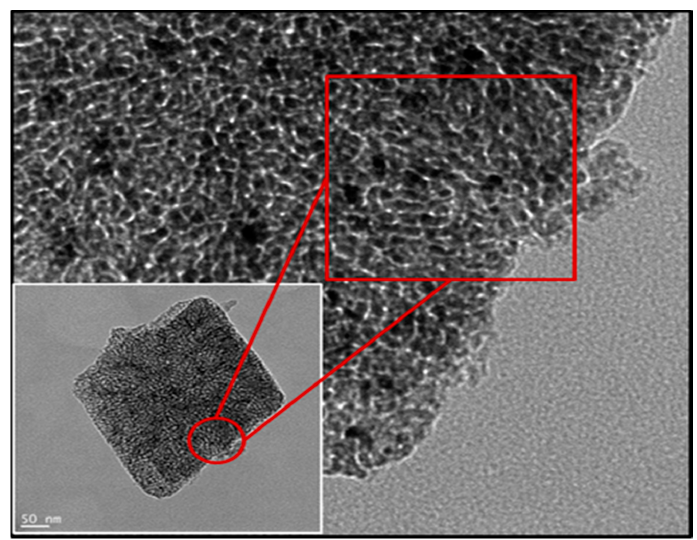
Figure 1. TEM image of an MgO powder particle. In the insert is a photo of a thin particle fragment on the micron scale, and the expanded picture is a higher-resolution image of it that shows the grains